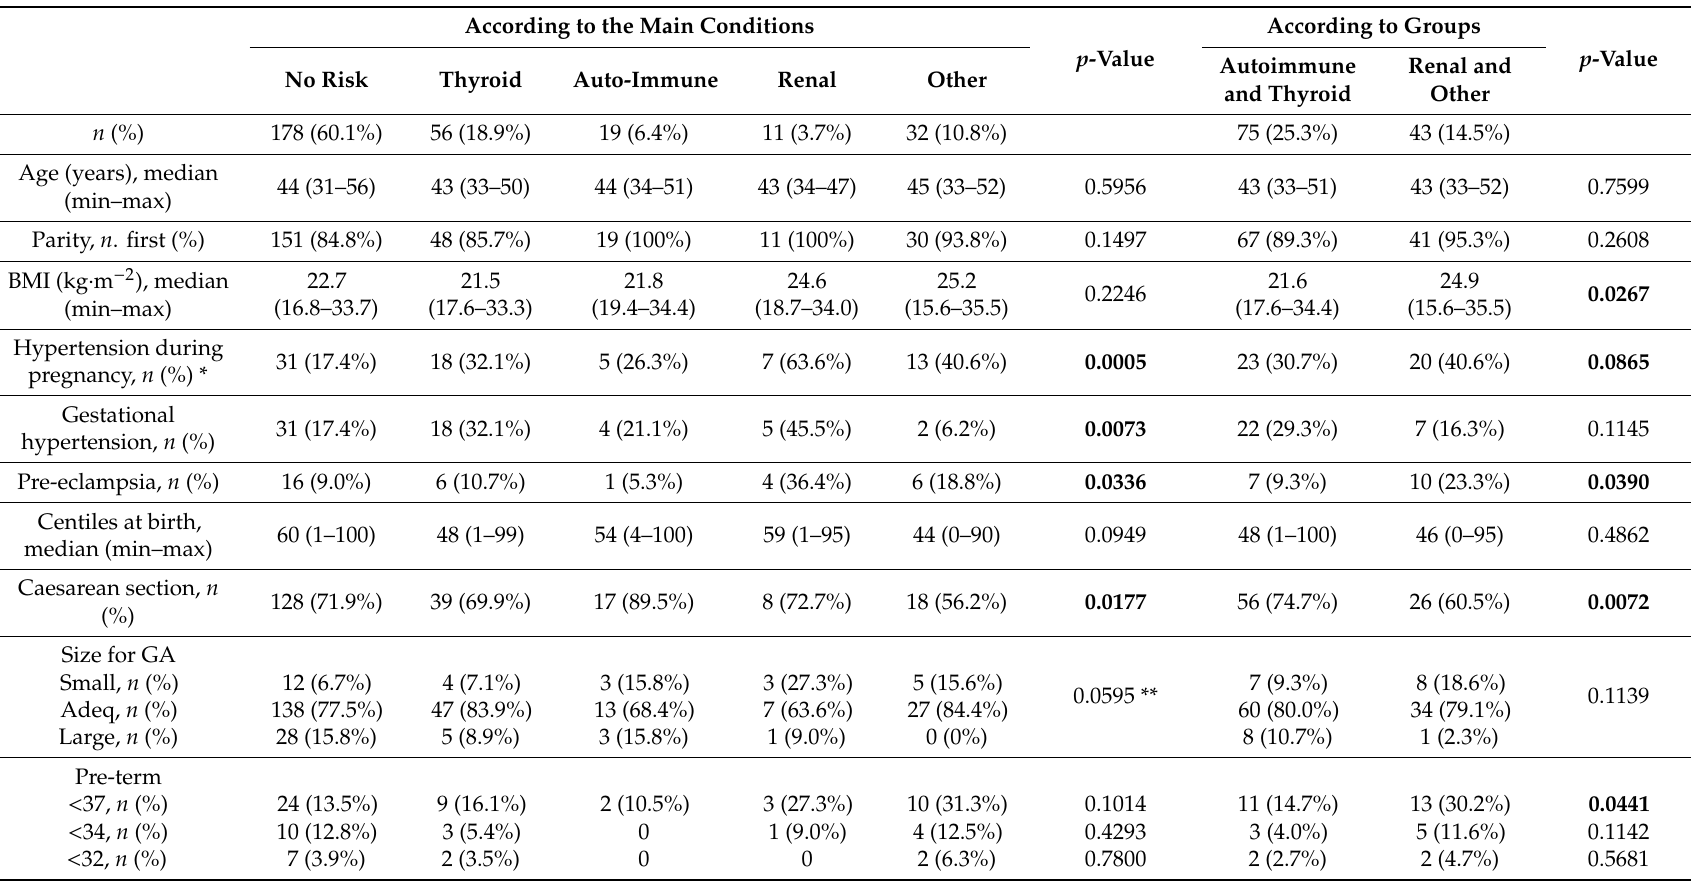
Table 2. Baseline and main delivery data in pregnancies from egg donation according to the comorbid conditions